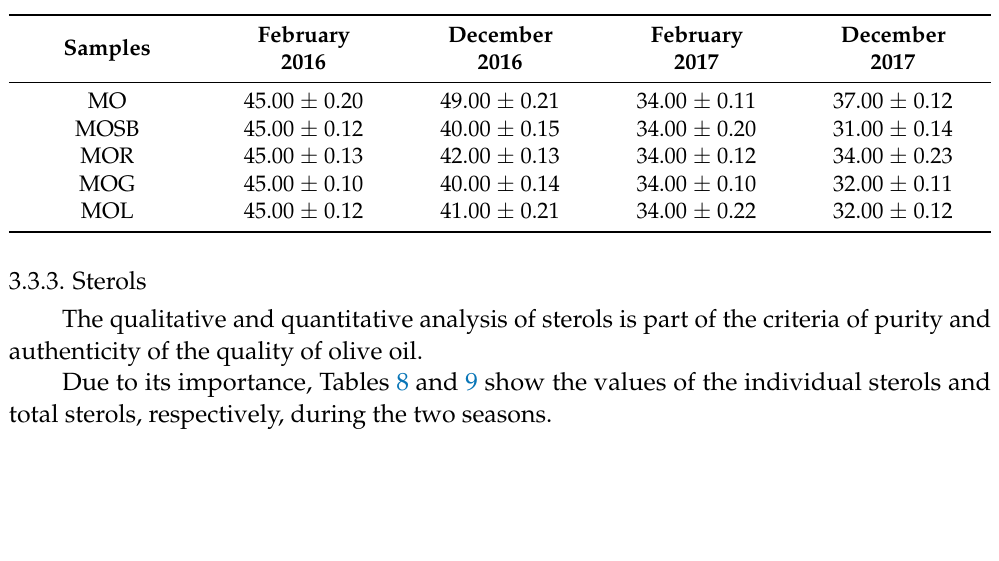
Table 7. Wax content (mg/kg oil) of all olive